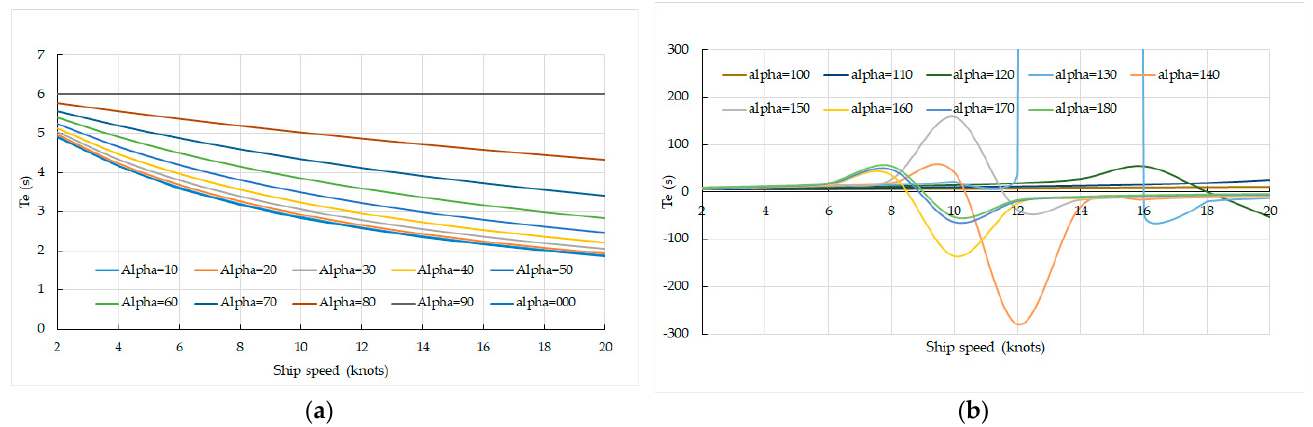
Figure 12. The Te for different combinations of ship speeds and α angles for a Tw = 6 s, ( a ) corre- sponding to α angles between 000° and 90° and ( b ) α angles between 100° and 180°.